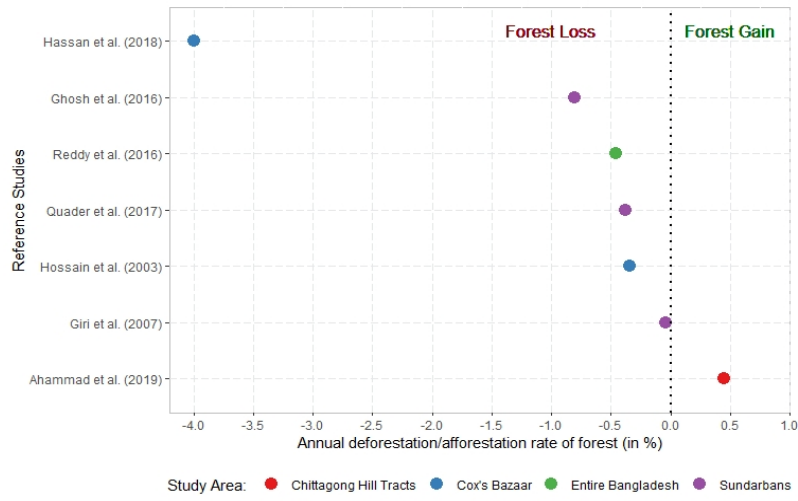
Figure 5. Forest cover loss/gain estimation by different studies